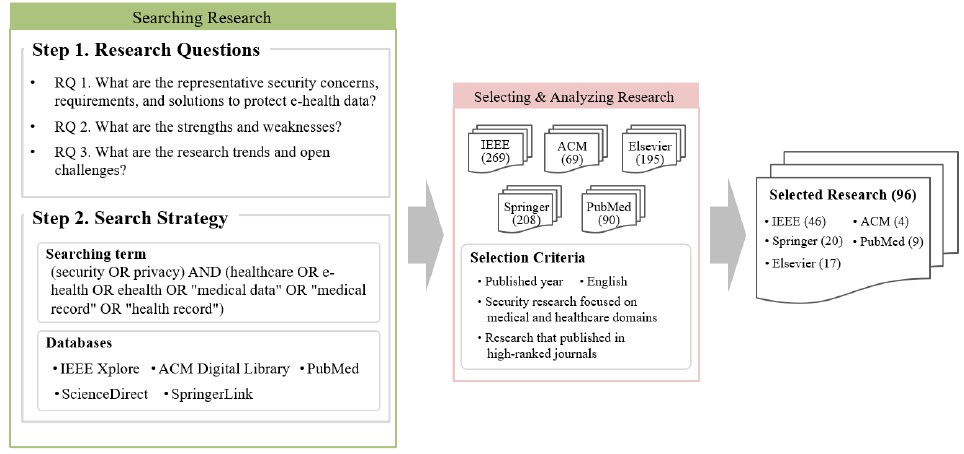
Figure 1. Overview of the literature review